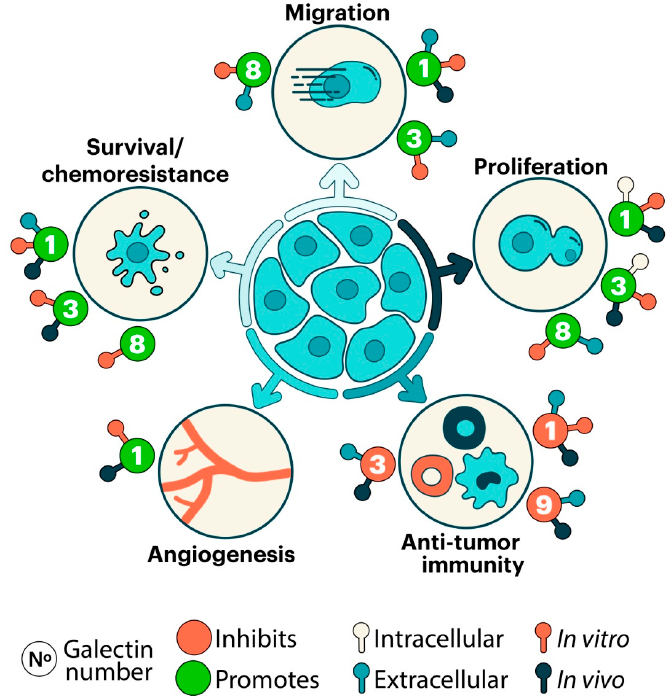
Figure 2. Galectins in glioma progression and tumor-associated inflammatory responses. Representation of biological functions of galectins in glioma cells (in vitro), or in animal models (in vivo). Galectins can promote a wide range of biological functions extracellularly by clustering multiple multivalent glycoconjugates, or intracellularly by modulating several signal transduction pathways, triggering intracellular oncogenic (proliferative and/or antiapoptotic) signaling. They can also bridge two cells of the same or different types, and bridge cells to extracellular matrix proteins, promoting migration and metastasis. In addition, galectin binding to extracellular glycoconjugates can induce angiogenesis, and affects immune responses in tumor